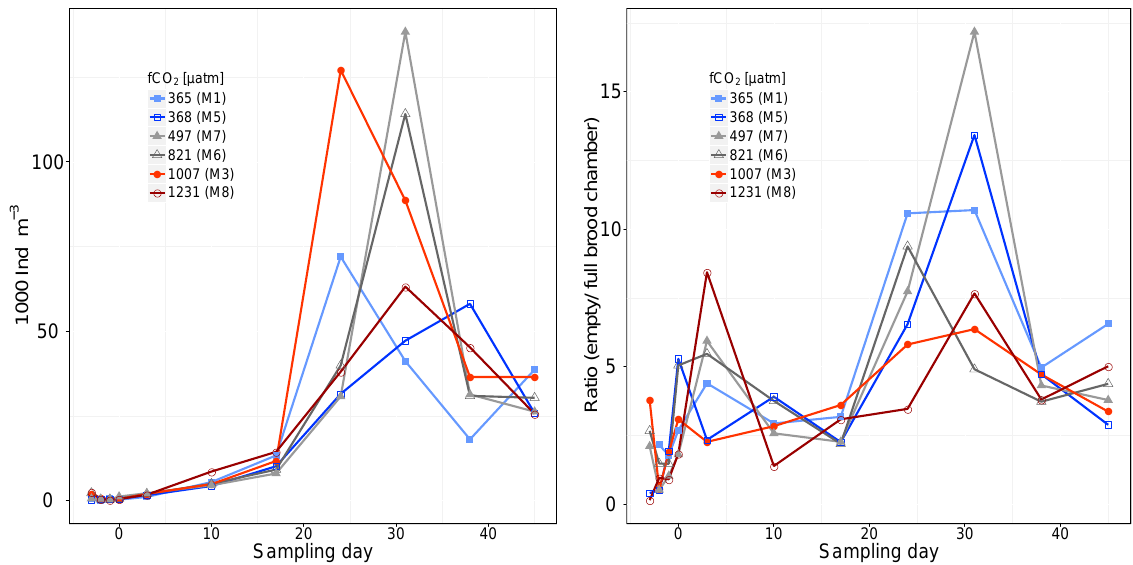
Figure 8. Left: total abundance of the most dominant cladoceran species Bosmina sp. Right: ratio of Bosmina with empty brood chambers to organisms with full brood chambers. Note: figure shows all data, but statistics were done on data from t 3 to t 45 only to assure equally spaced